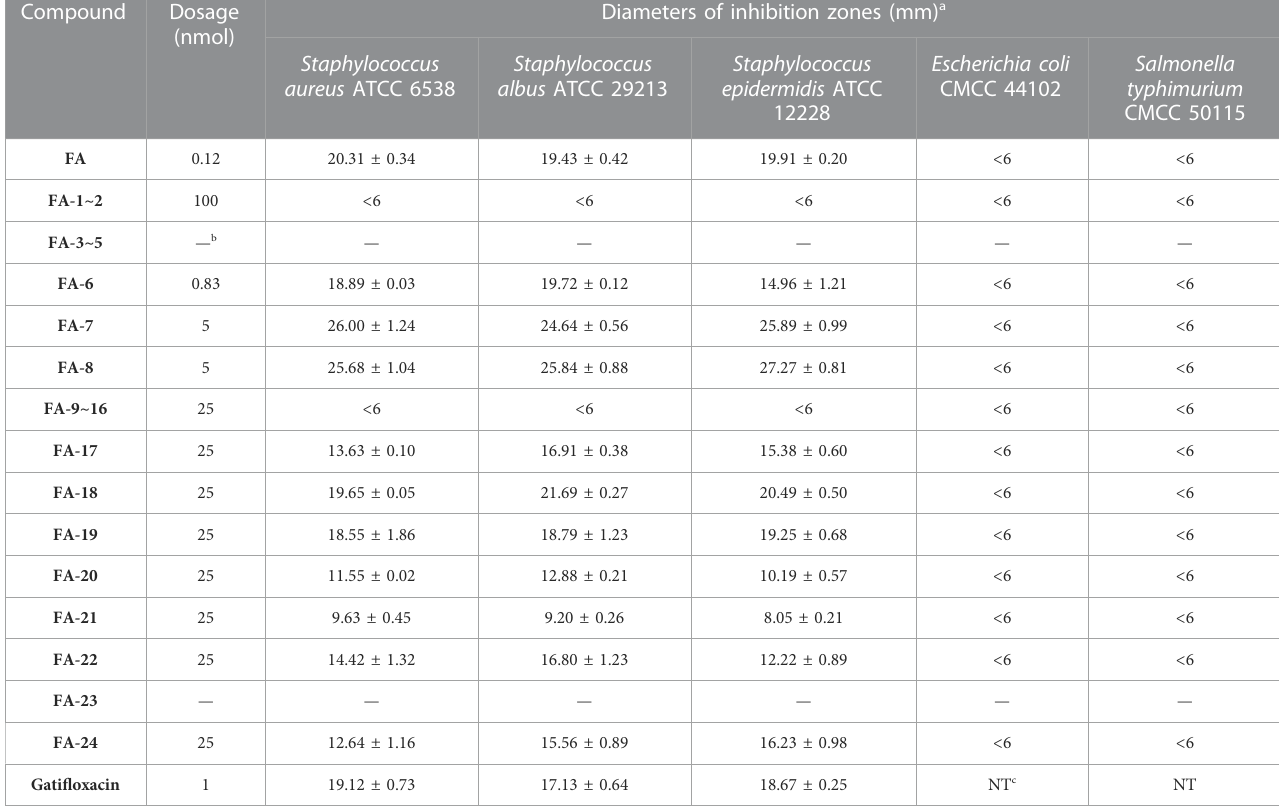
TABLE 3 The inhibition zone test of FA and its derivatives against bacterial strains.